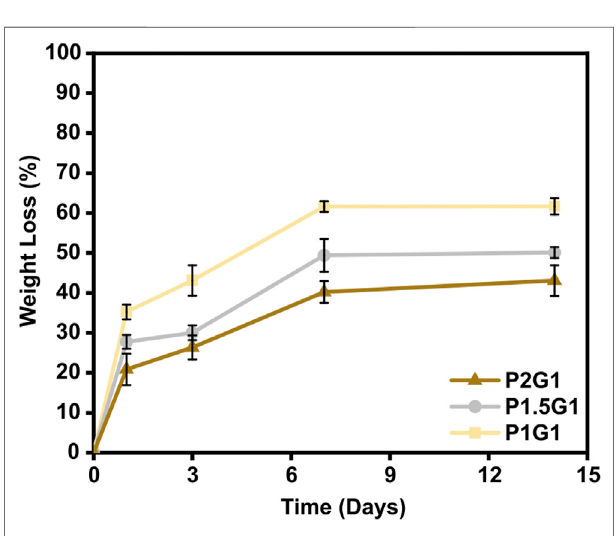
FIGURE 7 | In vitro weight loss curves of pristine hydrogels after 1, 3, 7 and 14 days of incubation in PBS at 37 ° C.